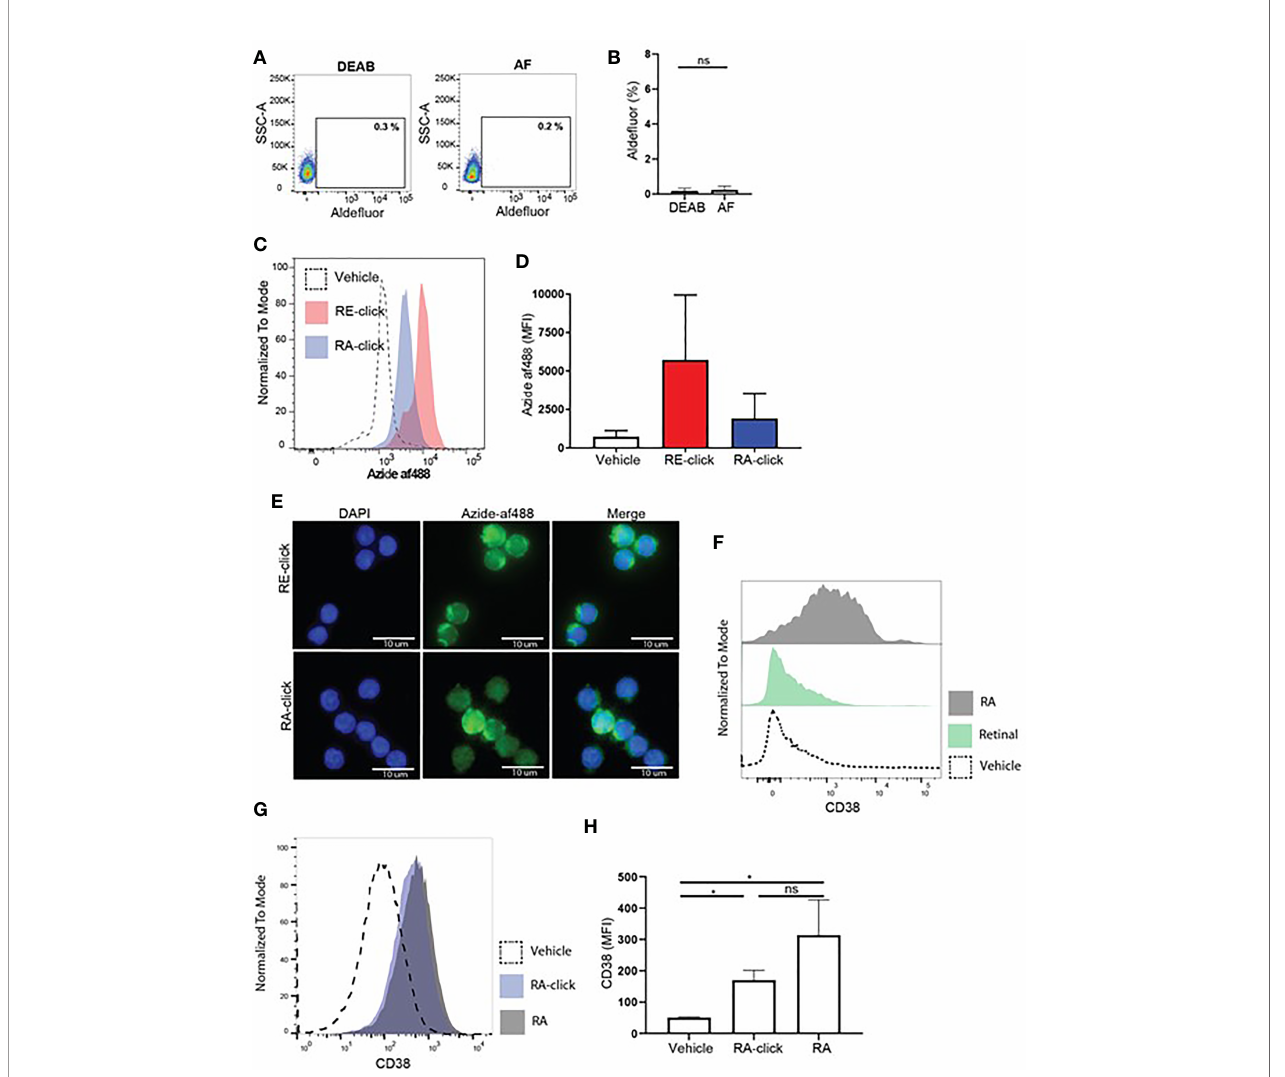
FIGURE 4 | Human naive B cells cannot produce retinoic acid, but are affected by exogenous retinoids to upregulate CD38 expression. Human naive B cells were isolated from peripheral blood. (A) Representative dot plot of alde fl uor positivity in naive B cells. DEAB reagent was used as a negative control. (B) Quanti fi cation of alde fl uor positivity in naive B cells from 3 different donors. (C) Representative histogram of the uptake of RE-click (pink) and RA-dick (blue) in naive B cells compared to vehicle control (dotted line). (D) Quanti fi cation of the uptake of RE-click and RE-click in naive B cells compared to vehicle control from 3 different donors. (E) Visualization of the RE- and RA-click using Azide-AF488 (green) with a nucleus staining (DAPI, blue) in naive B lymphocytes from 5 different donors. (F) Human naive B cells were isolated from peripheral blood and cultured in the presence of T cell dependent (TD) stimuli for 7 days, including interleukin-4, anti-CD40 and anti- IgM antibodies. Histogram of CD38 expression on B cells upon addition of unmodi fi ed retinal (green) or retinoic acid {grey) in comparison to vehicle control (dotted line). (G) Histogram of CD38 expression upon culturing with RA-click (blue), its unmodi fi ed counterpart retinoic acid (grey) and vehicle control (dotted line) during 7 day TC-dependent stimulation. (H) Quanti fi cation of CD38 expression upon culturing with the RA-click, its unmodi fi ed counterpart retinoic acid and vehicle control from 4 different donors. Data are presented as mean ± SD. ANOVA; *p < 0.05. ns indicates p >